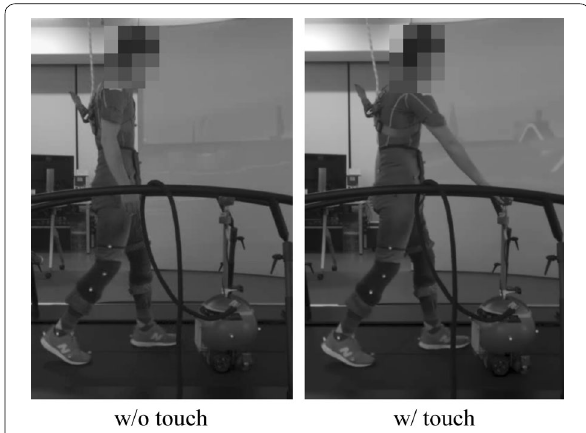
Fig. 10 Snapshots in the experiment. A subject is walking without touching (left) and with touching the cane robot with the right hand (right)